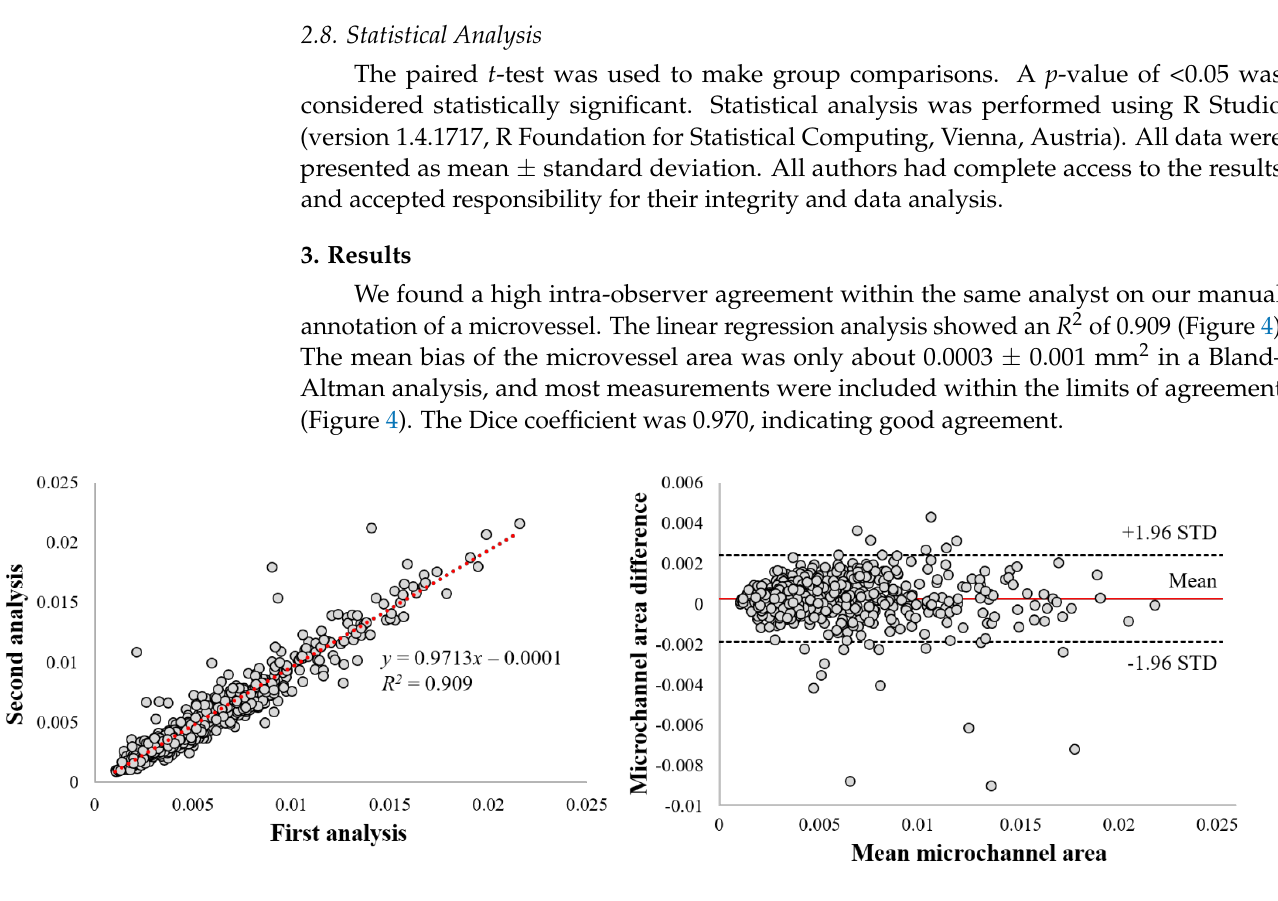
Figure 4. Intra − observer variability analysis of microvessel areas. Panels are as follows: ( left ) linear regression plot and ( right ) Bland − Altman plot. Linear regression gave R 2 = 0.909. Dice was 0.970. In the Bland − Altman analysis and the mean bias was only about 0.0003 ± 0.001 mm 2 , about 4.7% of the mean area. This result suggests excellent manual reproducibility within a single analyst.